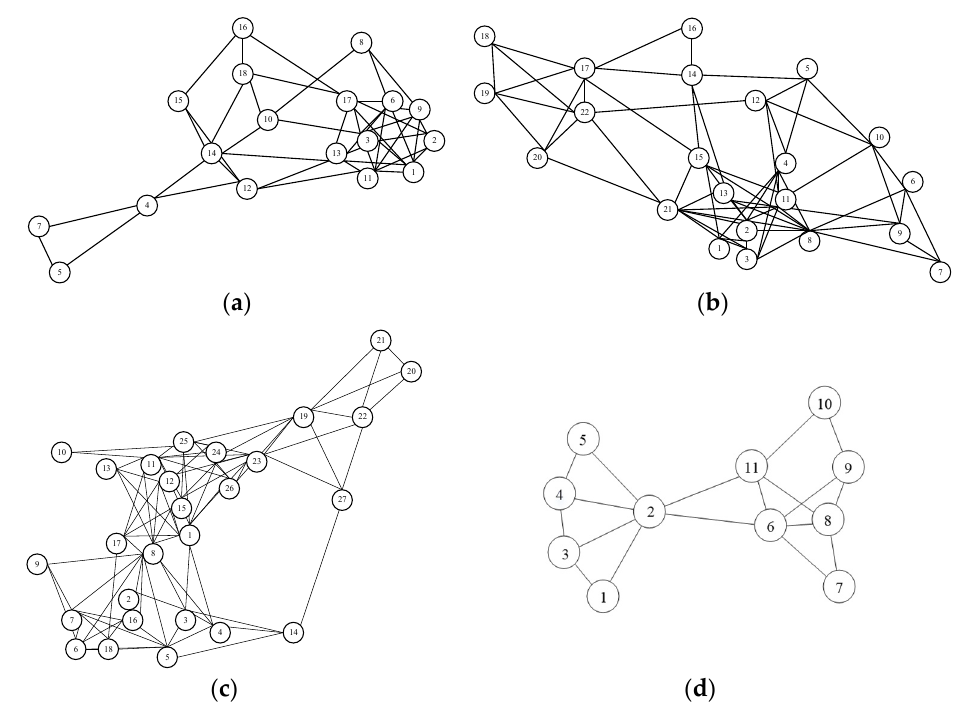
Figure 6. Team task complexity network models of screen door fault failures at GOA1–GOA4. ( a ) GOA1. ( b ) GOA2. ( c ) GOA3. ( d ) GOA4.